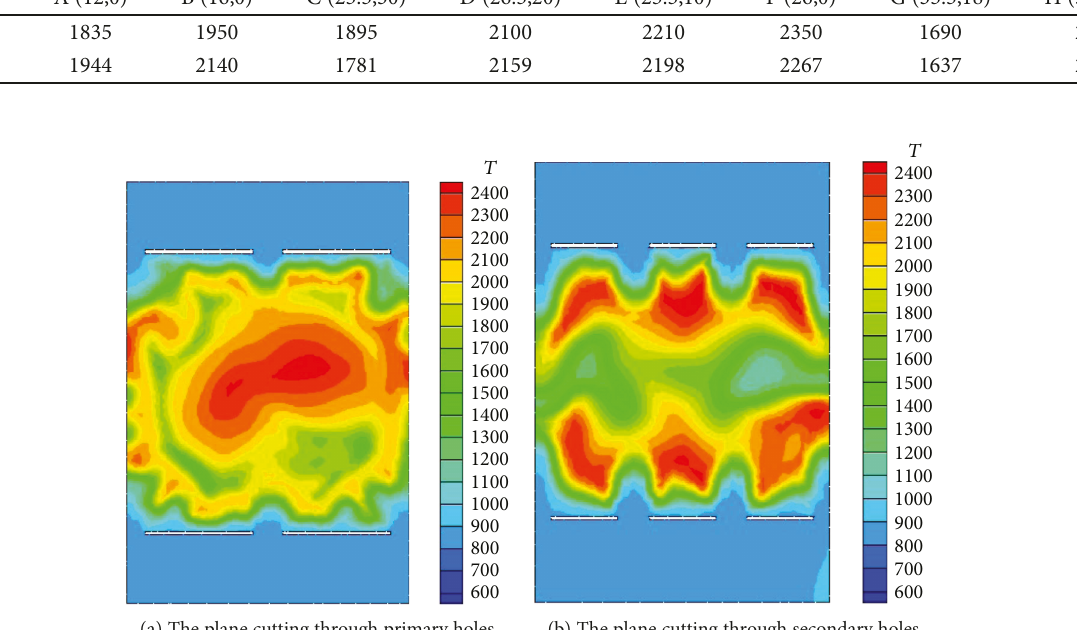
Figure 14: Temperature contour at the di ff erent selected